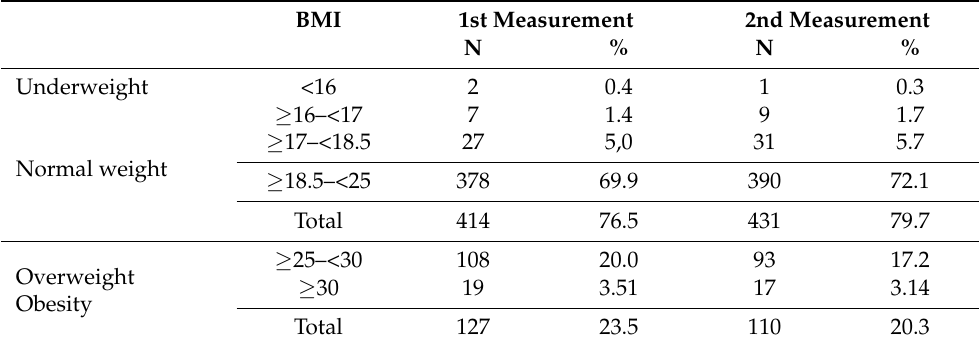
Table 4. Anthropometric measures of children before and after the interventions according to the classification of the International Obesity Task Force (IOTF [36]) 1 . BMI 1st Measurement 2nd Measurement